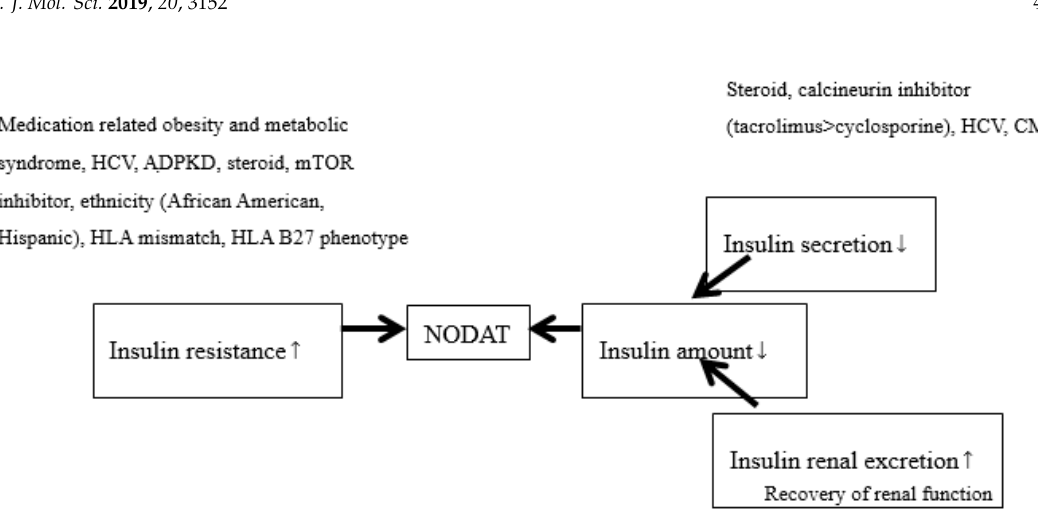
Figure 1. The pathogenesis of new-onset diabetes after transplantation (NODAT). Smaller arrows indicate increase (upward) and decrease (downward). Larger arrows indicate the cause.